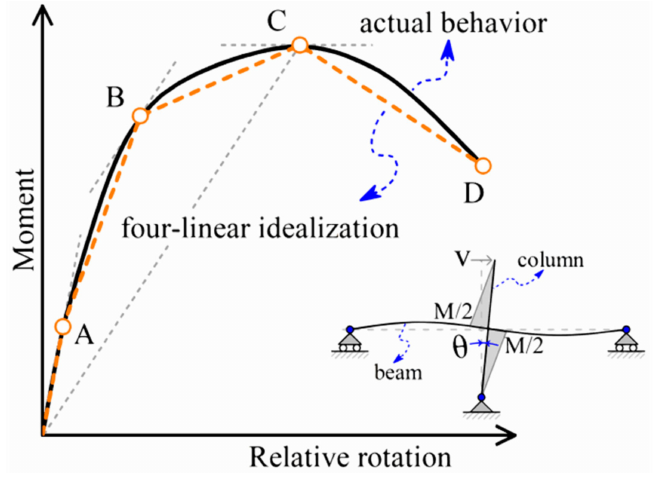
Figure 1. Idealization of moment–rotation